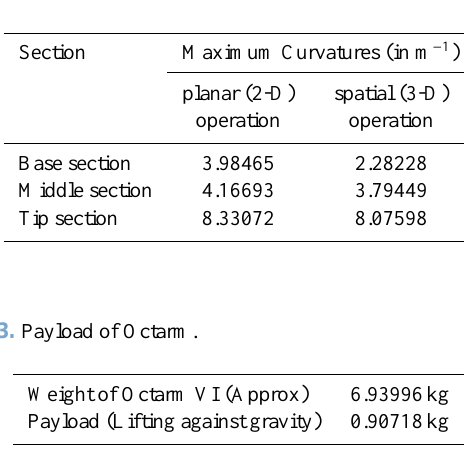
Table 4. Actuator